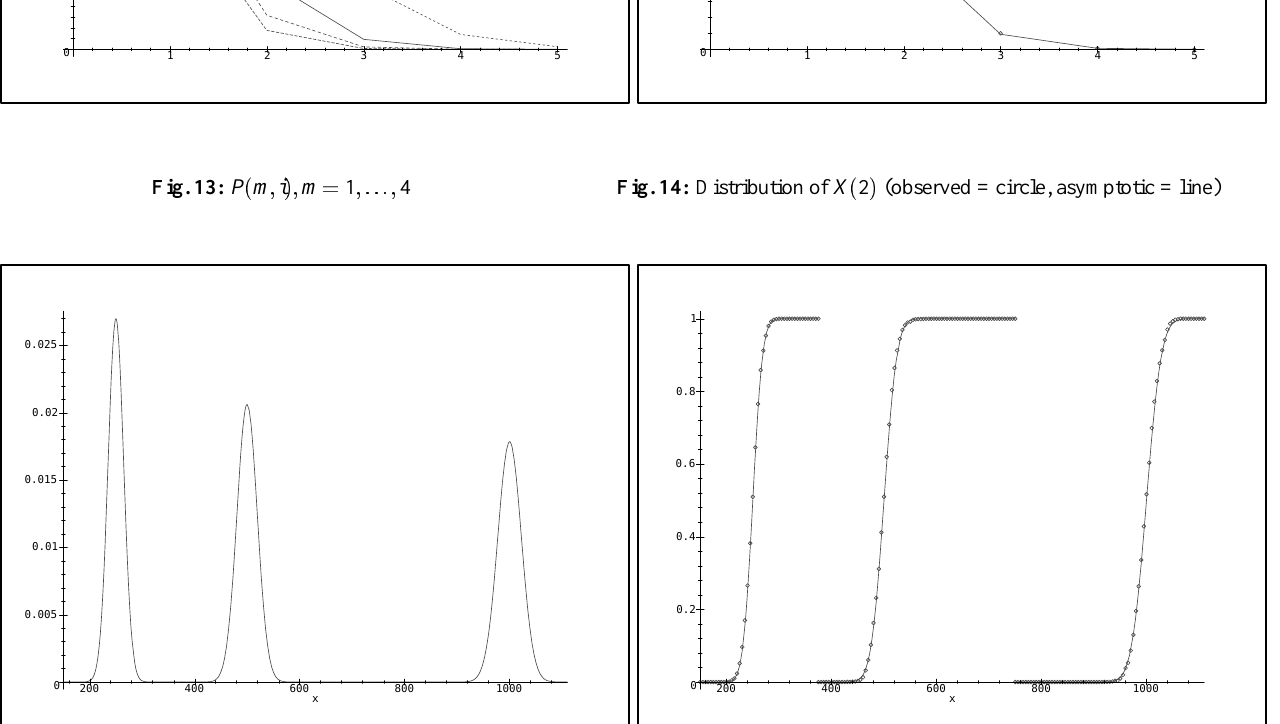
3 Fig. 16: Distribution function of M i (cid:2)(cid:0)(cid:0)(cid:0)(cid:2)